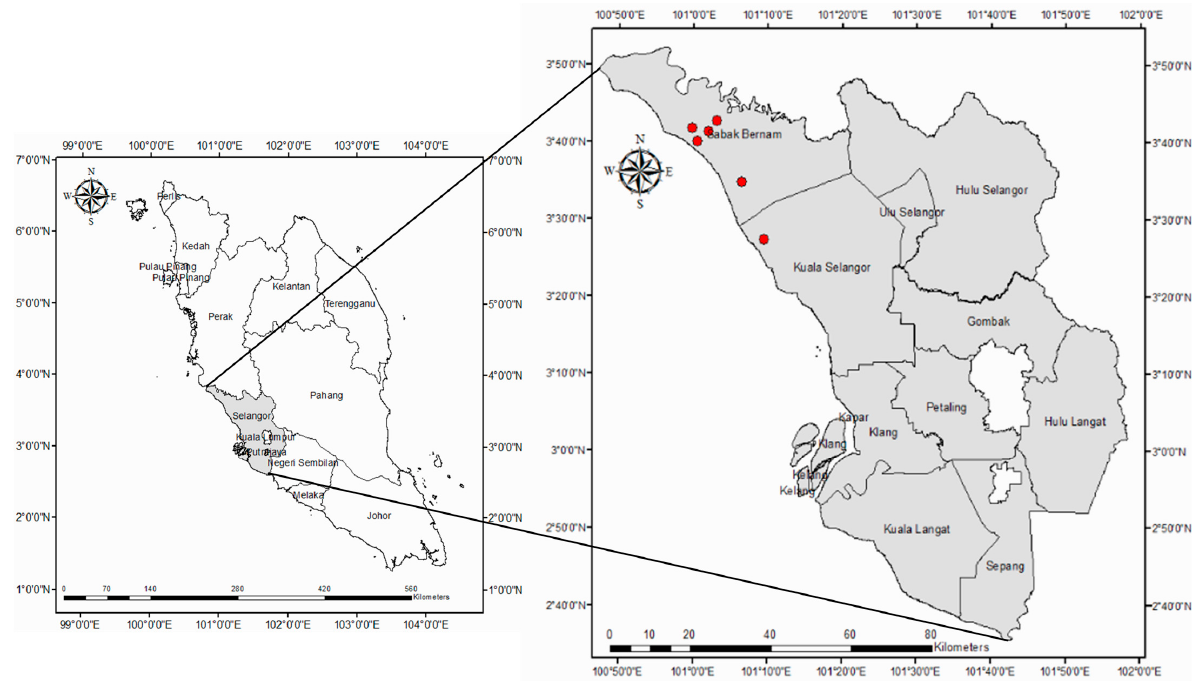
Figure 1. Locations of sample collection from wetland rice fields in the state of Selangor, Peninsular